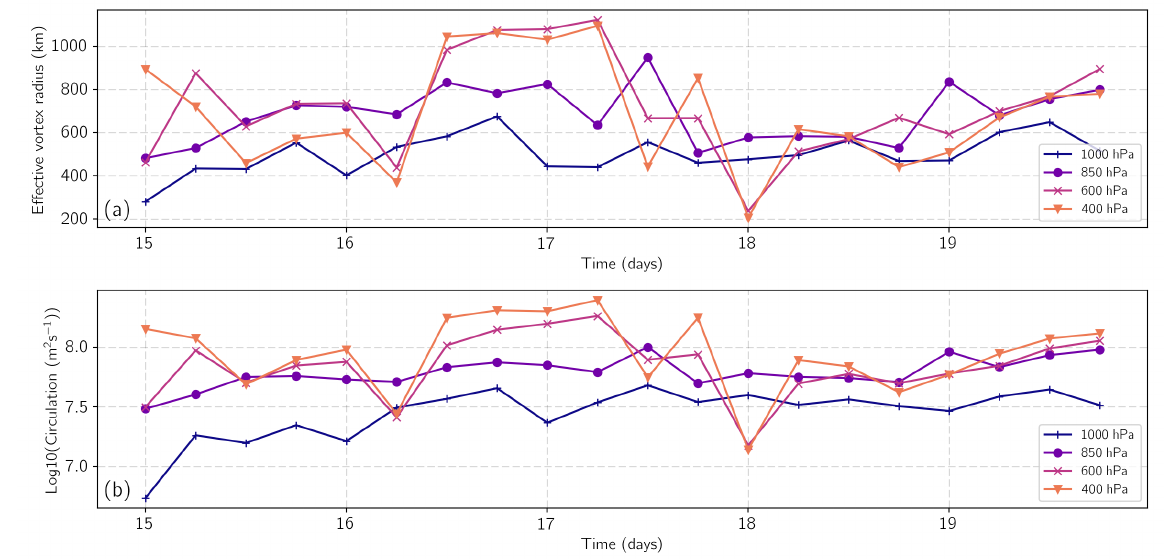
Figure 4. Properties of Kyrill over its lifetime derived from six-hourly NCEP data at different height levels: